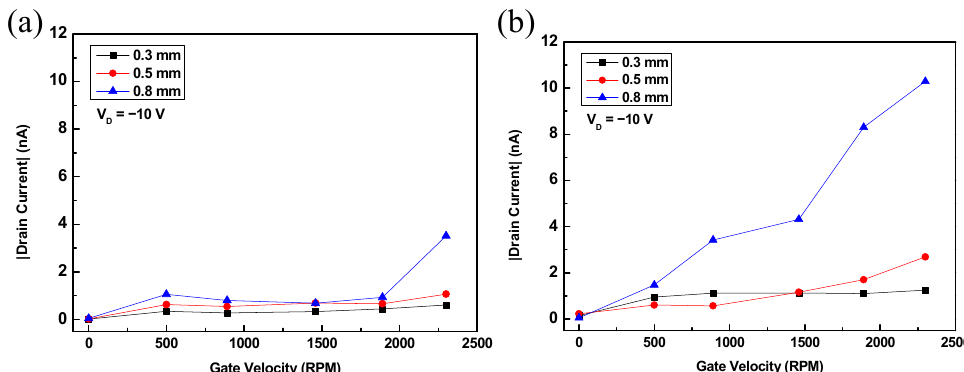
Figure 2. Transfer characteristics of the rotating gate transistor (RGTs) with active layers deposited using ( a ) spin-coating and ( b ) drop-casting techniques and dielectric layers of various thicknesses. The thickness of the dielectric layer of the device represented with squares, circles, and triangles in the graphs was 0.3, 0.5, and 0.8 mm, respectively.